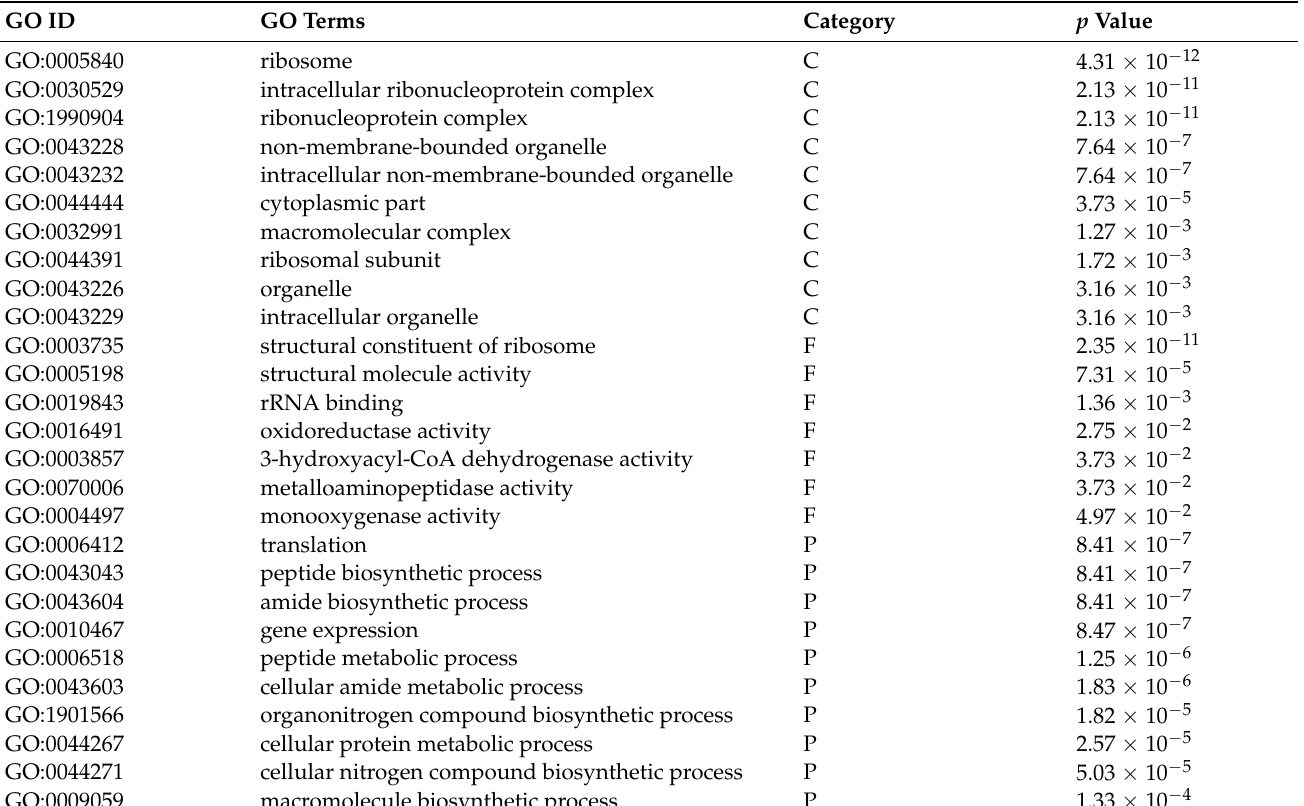
Table 3. Gene ontology (GO) enrichment analysis for increased abundance proteins in PL before thermal